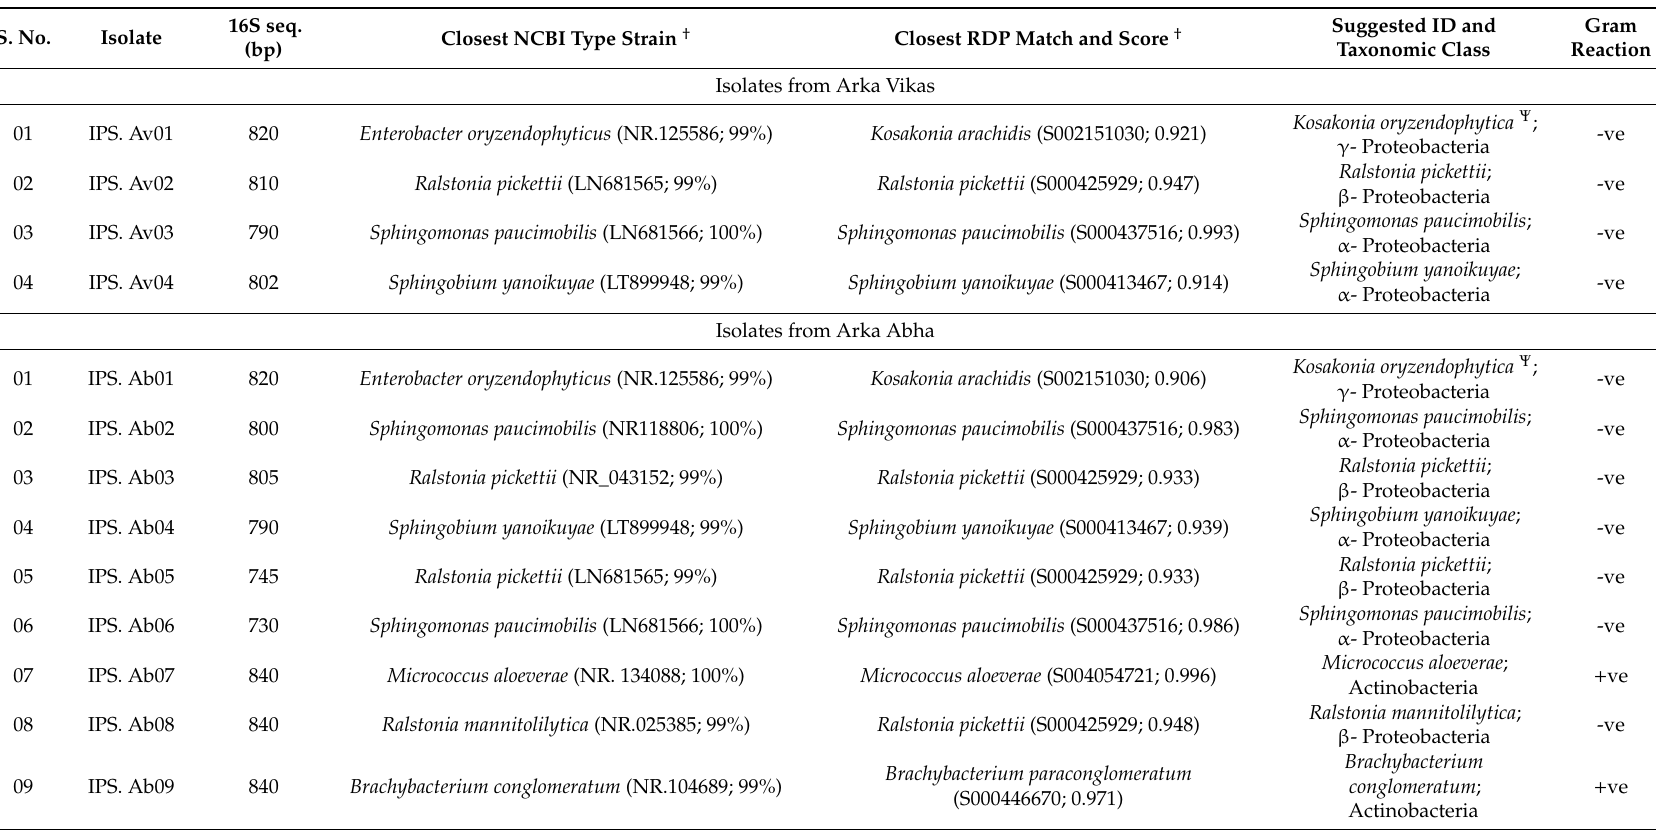
Table 1. Identification of bacterial strains isolated from 30-day-old in vitro grown bacteria index-positive seedlings of tomato “Arka Vikas” and “Arka Abha”. S.